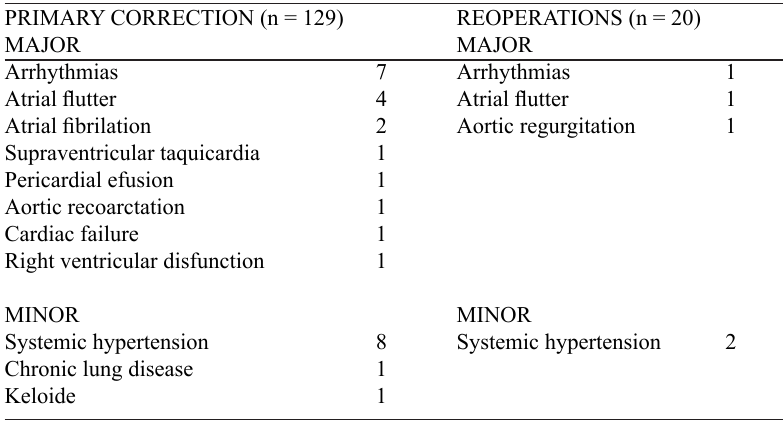
Table 3. Late postoperative complications and comorbidities diagnosed in 149